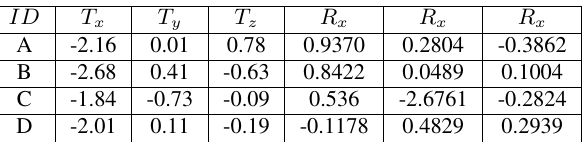
Table 5: Translation (cm) and rotation (deg) parameters between RGB and IR camera